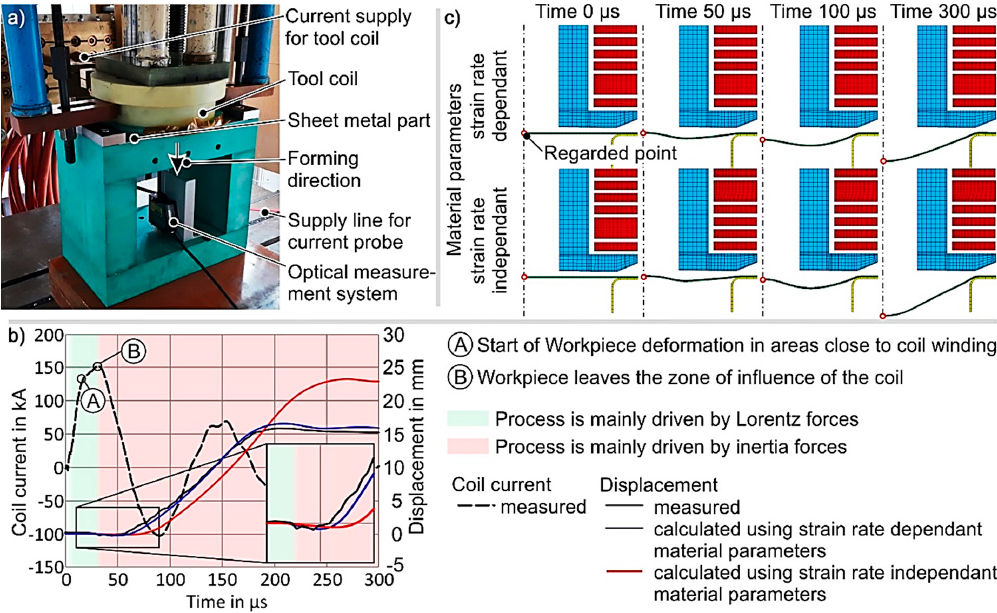
Figure 21. Verification of the identified material parameters of DC06: ( a ) test setup, ( b ) current course and comparison of experimentally and numerically determined displacement courses, ( c ) numerically determined forming